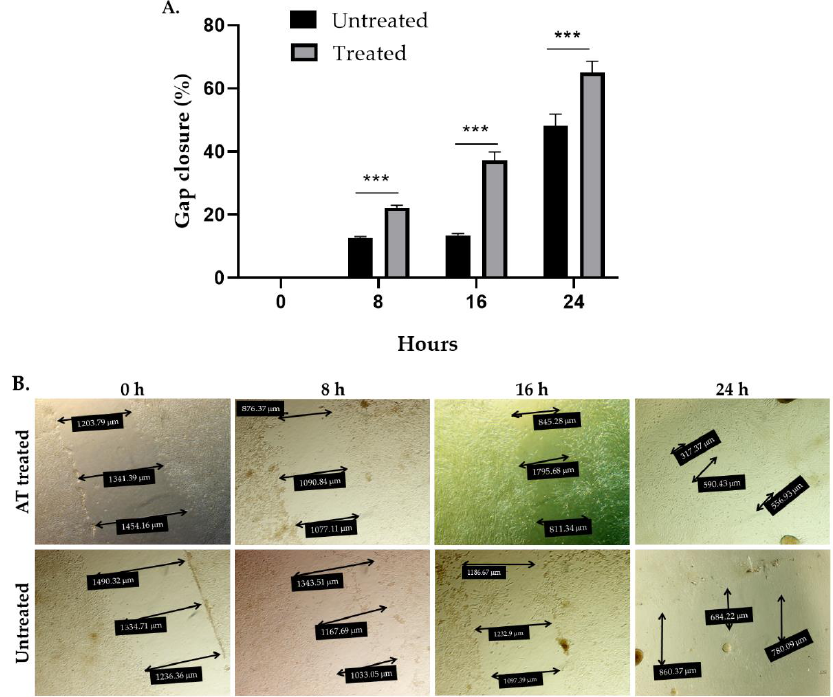
Figure 5. In vitro wound healing effect of Arnica tincture. The graph in ( A ) represents the mean ± standard deviation ( n = 4) in the percentage of gap closure. *** Treatment with AT shows a statistically significant ( p < 0. 001) increase in the percentage of gap closure in comparison to the untreated cells after 8 h, 16 h and 24 h of incubation vs. untreated cells. ( B ): Photographic documentation of a representative experiment showing the migration of cells into the gap area under exposure to Arnica tincture. The double arrows indicate cell free areas. Their diameters are reported in the black boxes.